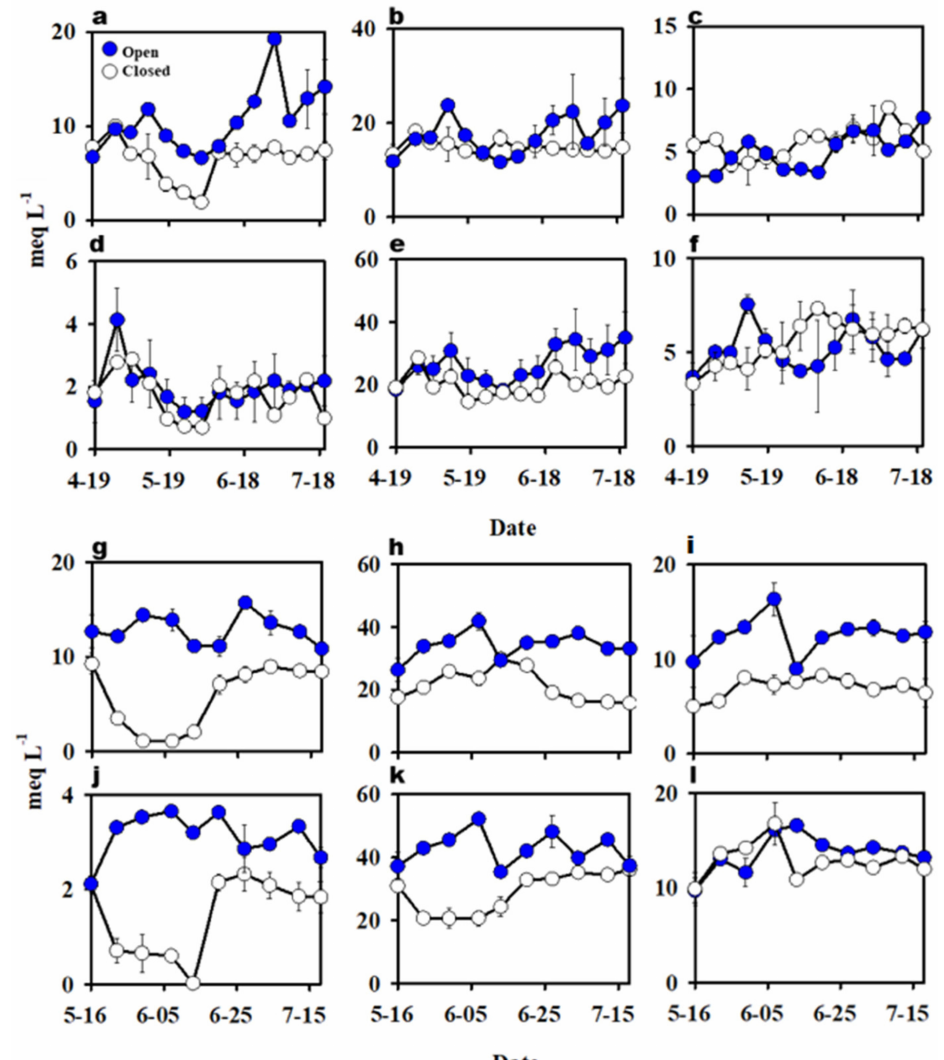
Figure 3. Changes in ion concentration under the nutrient balance control in the experimental- ( a – f ) and commercial- ( g – l ) scale experiments: K + ( a , g ), Ca 2+ ( b , h ), Mg 2+ ( c , i ), H 2 PO 4 − ( d , j ), NO 3 − ( e , k ), and SO 42 − ( f , l ). P -phase: 19 April–1 June ( a – f ), 16 May–13 June ( g – l ), S -phase: 8 June ( a – f ), 20 June ( g – l ), A -phase: 8 June–18 July ( a – f ), 20 June–15 July ( g – l